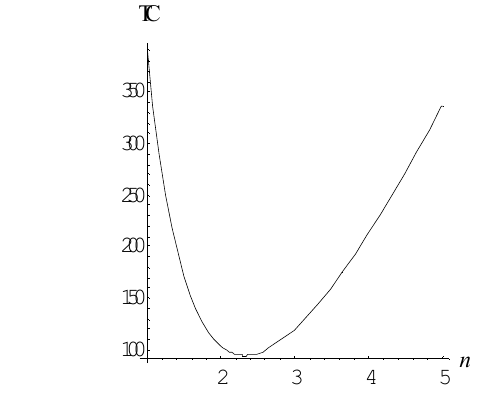
Fig 8.(b) The effect of parameter n on the total cost in the fuzzy model